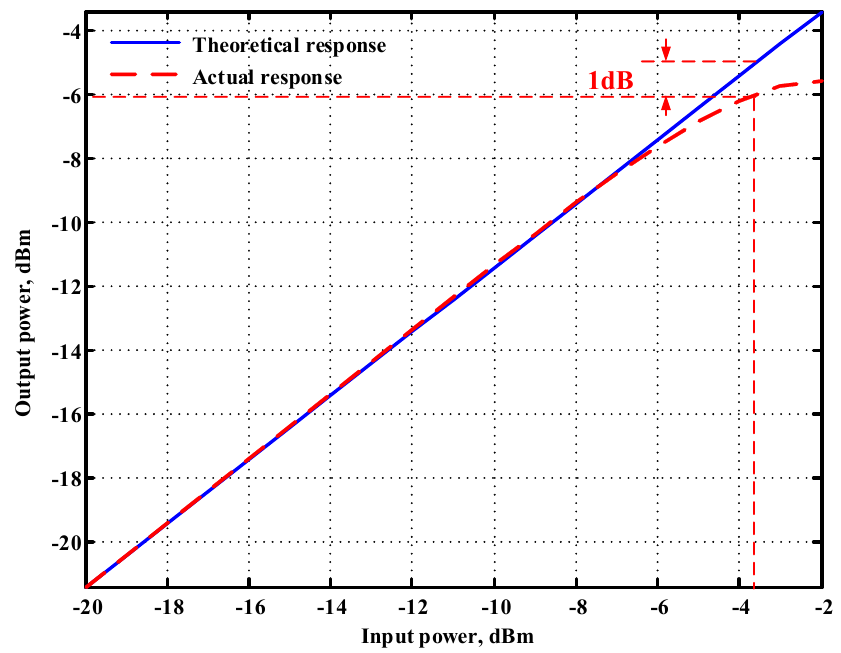
Figure 21. Measured P1dB of the BP filter with the input power of the voltage output V o3 .